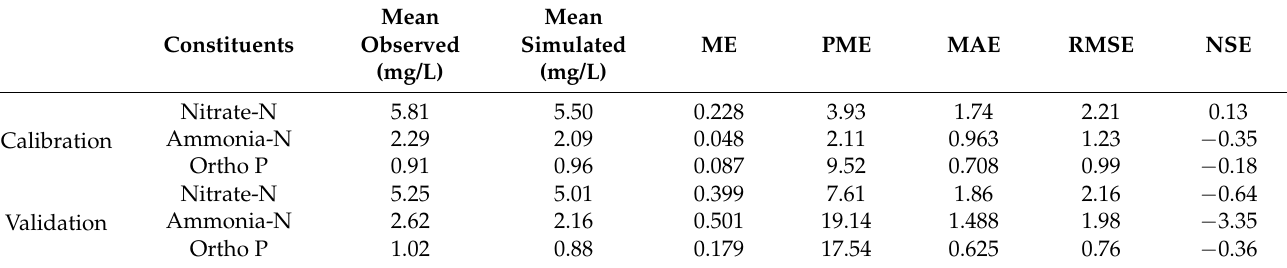
Table 7. Water quality calibration and validation statistical